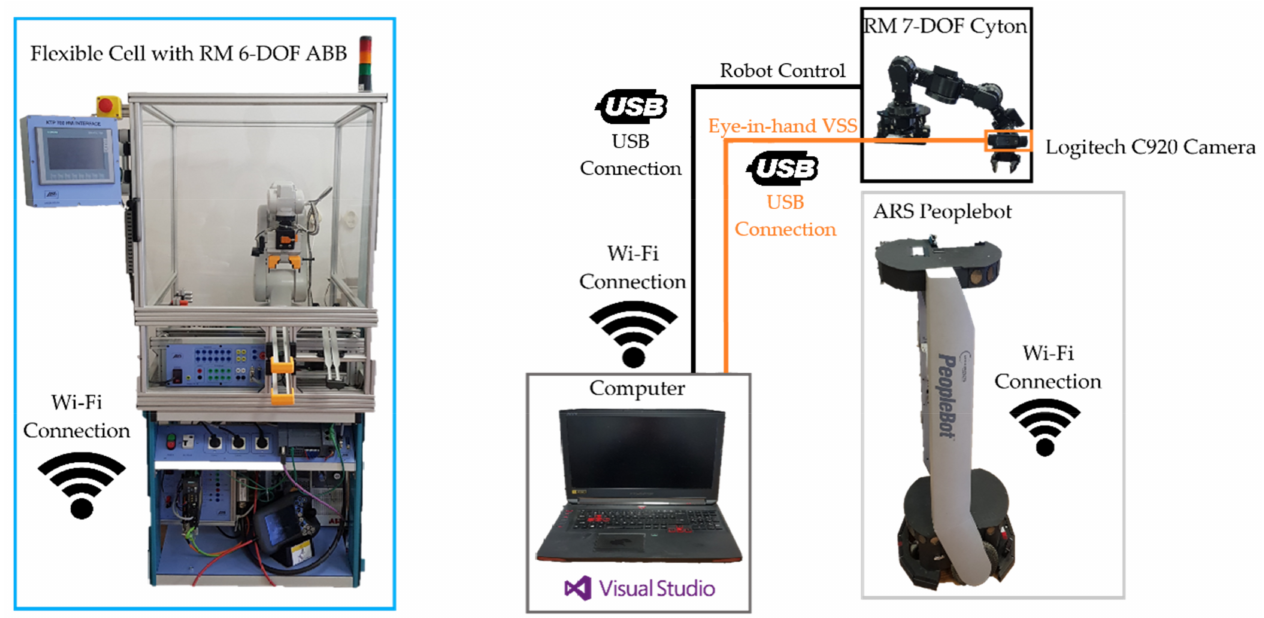
Figure 14. Communication block set of the computer between the FC, ARS PeopleBot WMR equipped with the Cyton RM and eye-in-hand VSS.